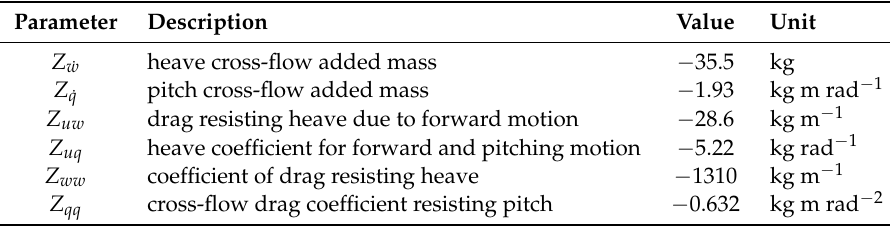
Table A5. Parameters of the heave equation of motion taken from [24].